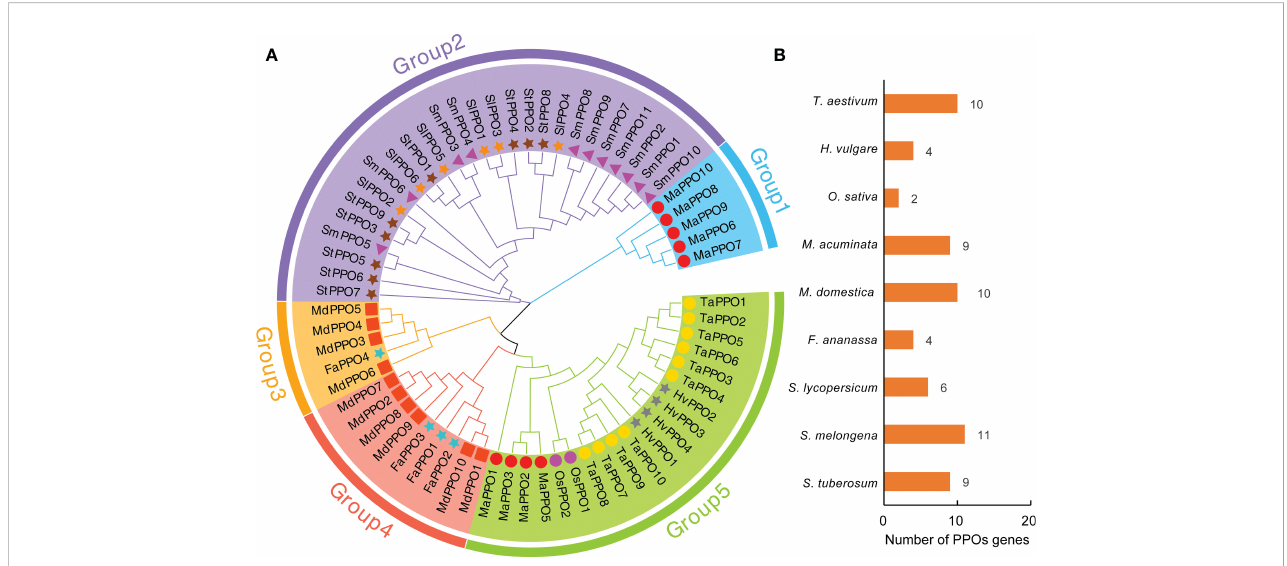
FIGURE 1 Phylogenetic analysis of PPO proteins in nine plant species. (A) Phylogenetic relationship of PPO proteins from Musa acuminate (MaPPO), Malus domestica (MdPPO), Oryza sativa (OsPPO), Solanum lycopersicum (SlPPO), Solanum tuberosum (StPPO), Triticum aestivum (TaPPO), Hordeum vulgare (HvPPO), Fragaria ananassa (FaPPO), and Solanum melongena (SmPPO). The phylogenetic tree was built using the neighbor-joining (NJ) method implemented in MEGA11 with 1000 bootstrap replicates. The PPOs identi fi ed from different species are indicated by different shapes and colors in front of the node. (B) Presentation of PPO protein numbers across nine plant